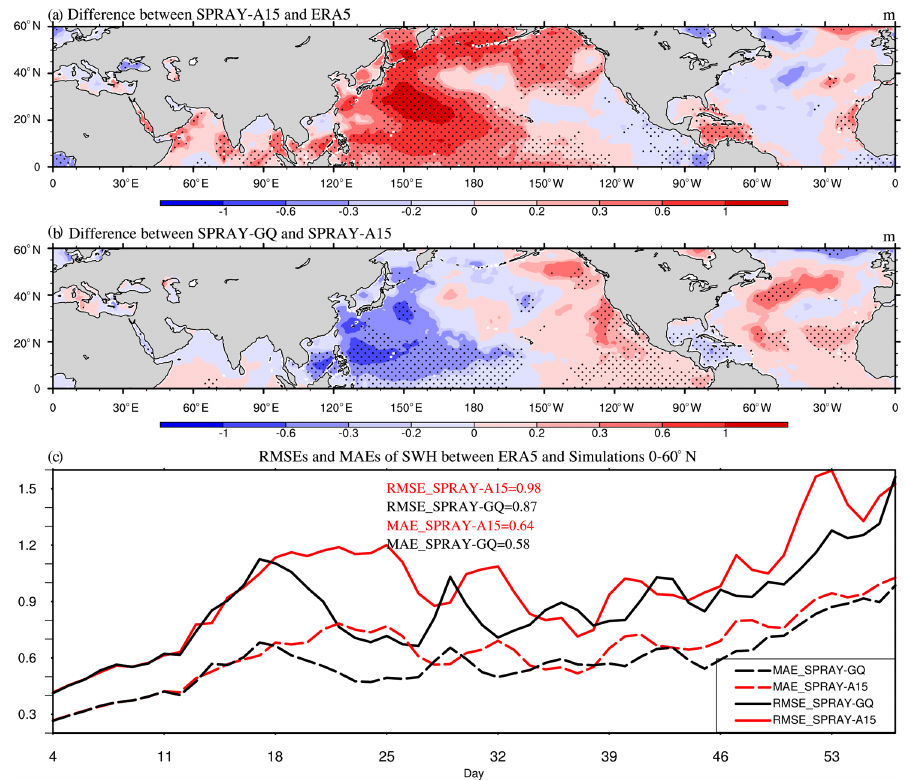
Figure 13. The same as Fig. 12, but for August–September